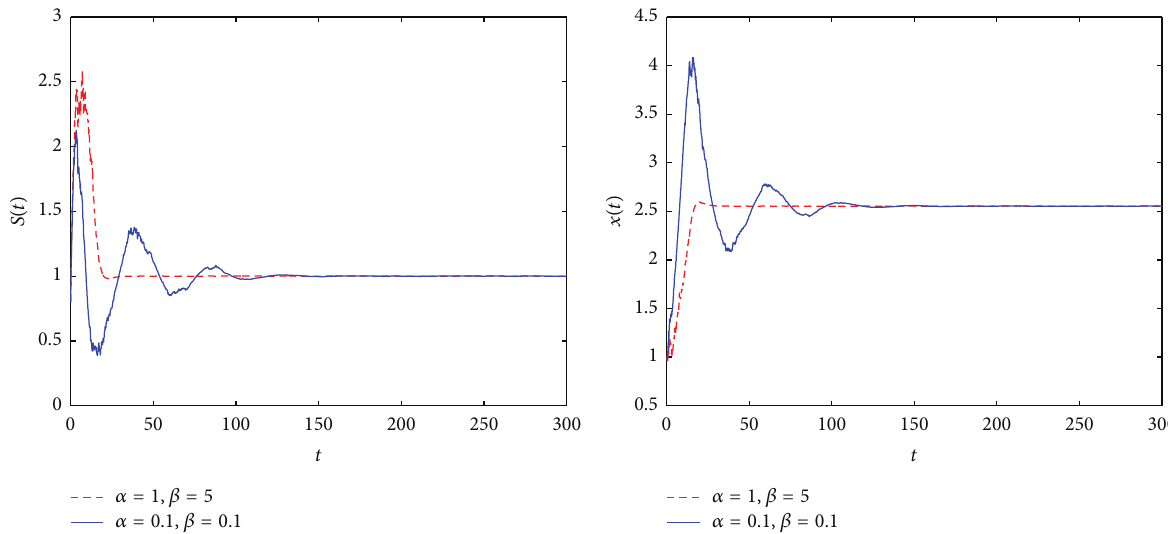
Figure 3: The dynamics of stochastic functional model with different 𝛼, 𝛽 . Here 𝑆(0) = 0.3 , 𝑥(0) = 0.5 , 𝑦(0) = 0.3 , 𝑧(0) = 0.5 .